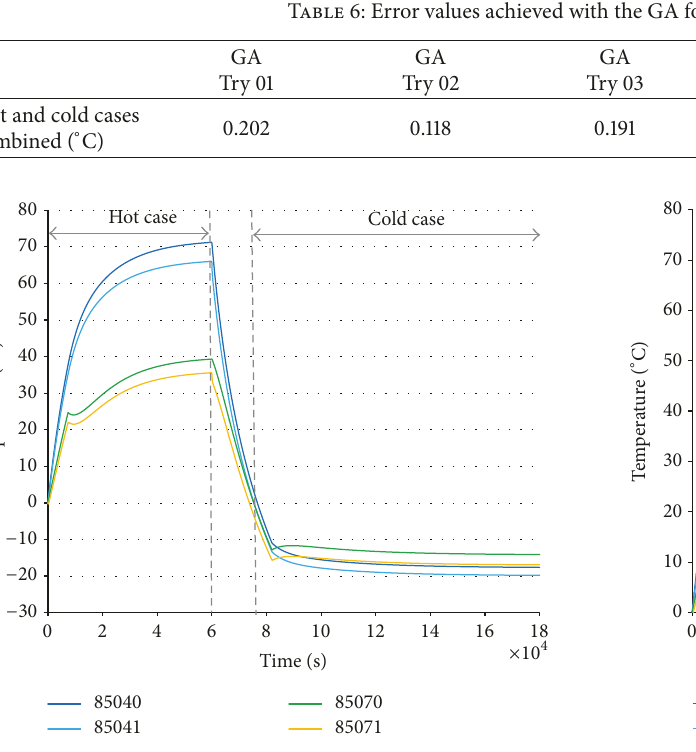
Figure 6: Transient hot and cold cases combined sequentially.